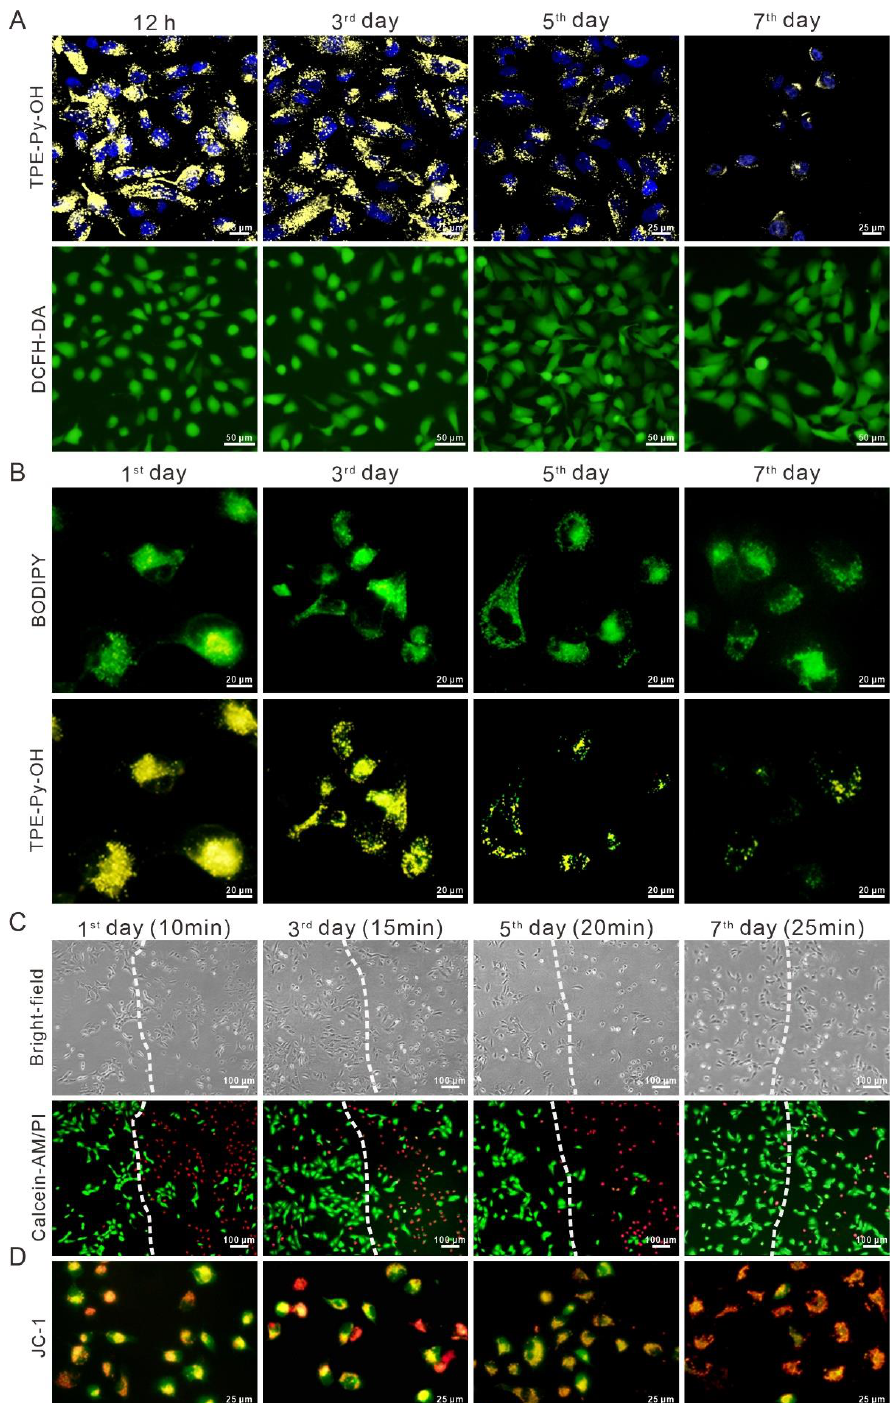
Figure 4. Long-term tracking and PDT effect of HepG2 cells stained with 10 µ M TPE-Py-OH for 12 h and continuously cultured for different time. ( A ) Fluorescent images of TPE-Py-OH and intracellular ROS generation after light irradiation (450 nm, 30 mW/cm 2 , 10 min). ( B ) Co-staining of HepG2 cells stained with TPE-Py-OH and continuously cultured for different time, followed by staining with 1 μg/mL BODIPY for 30 min. ( C ) Fluorescence images stained with calcein-AM/PI of HepG2 cells cultured for different time. left part of the dotted line: without light irradiation, right part of the dotted line: with light irradiation. ( D ) Fluorescence images stained with JC-1 of HepG2 cells cultured for different time with